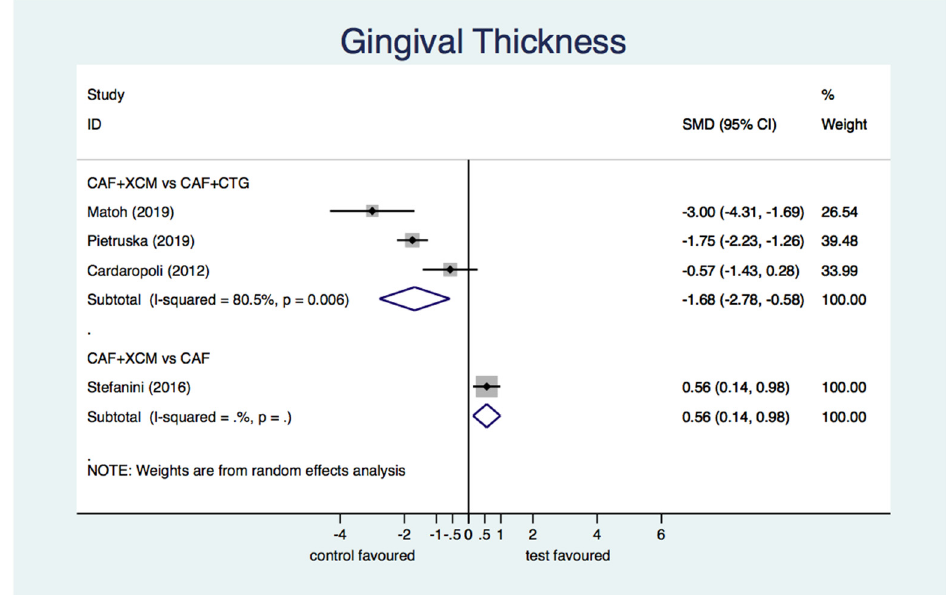
Figure 9. Forest plot relating to gingival thickness.